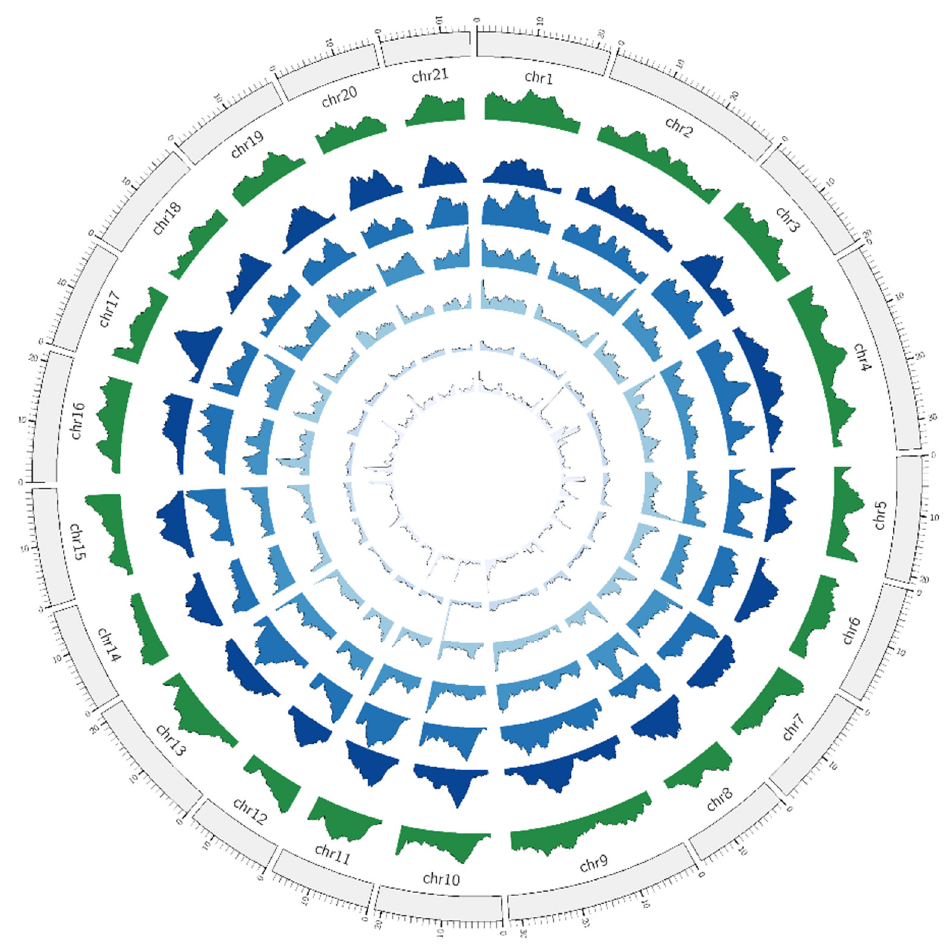
Figure 3. Association analysis of perfect microsatellites in the Siamese fighting fish genome. Circos was used to plot the assembled chromosomes and perfect microsatellite density. The outermost layer shows the chromosomes with numbers indicating the length in Mb. The dark green layer indicates the distribution of perfect microsatellites in 3 Mb windows with 100 kb steps. The blue gradient layer indicates the distribution of perfect microsatellites from mono (darkest blue) to hexa (lightest blue) in 3 Mb windows with 100 kb steps.